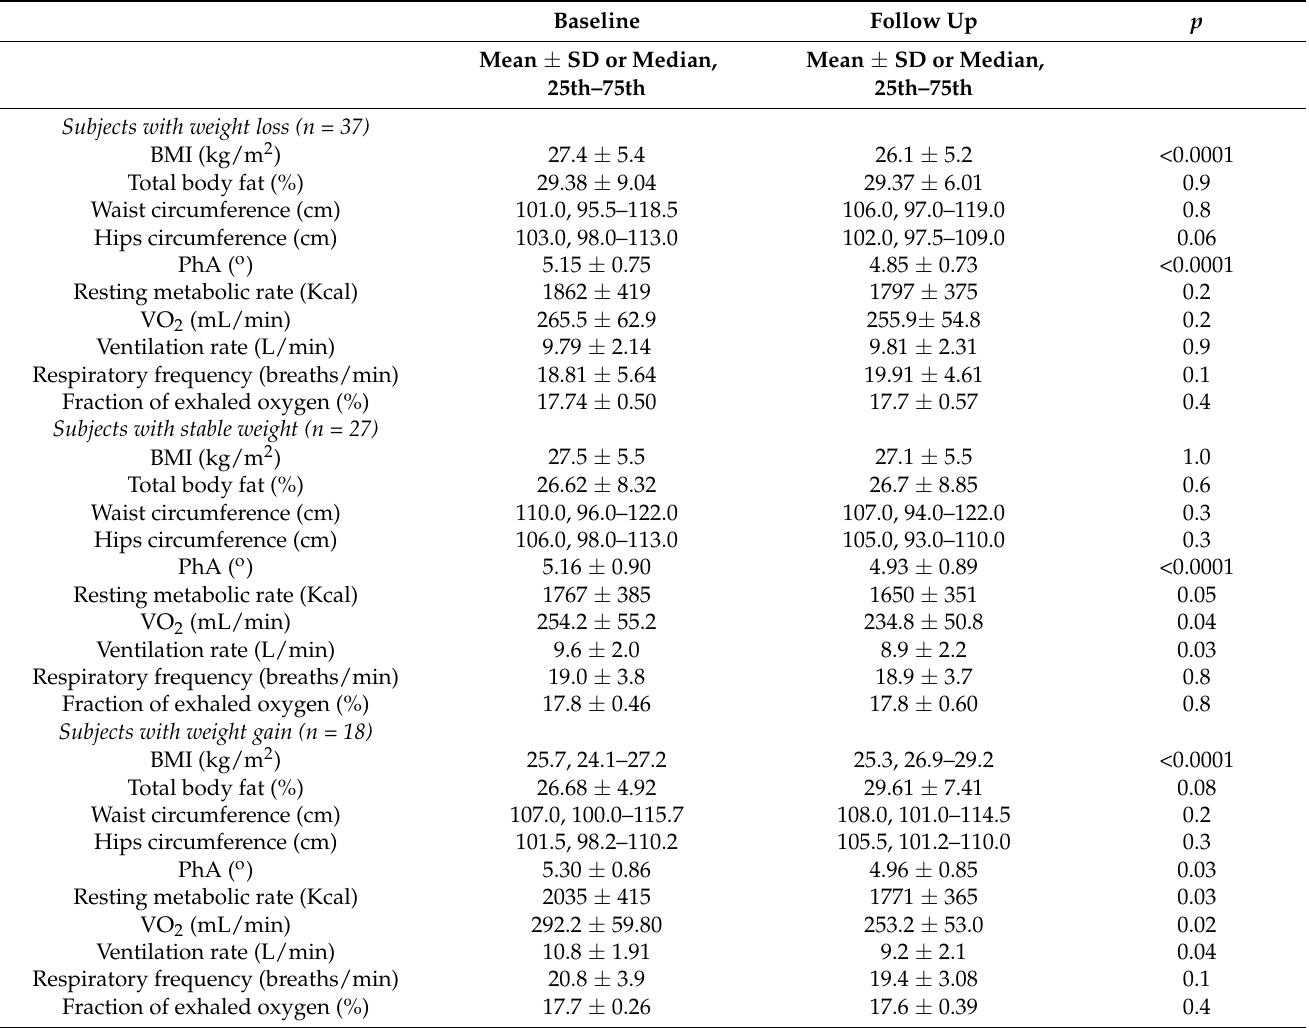
Table 3. Changes in body composition and resting metabolic rate according to weight